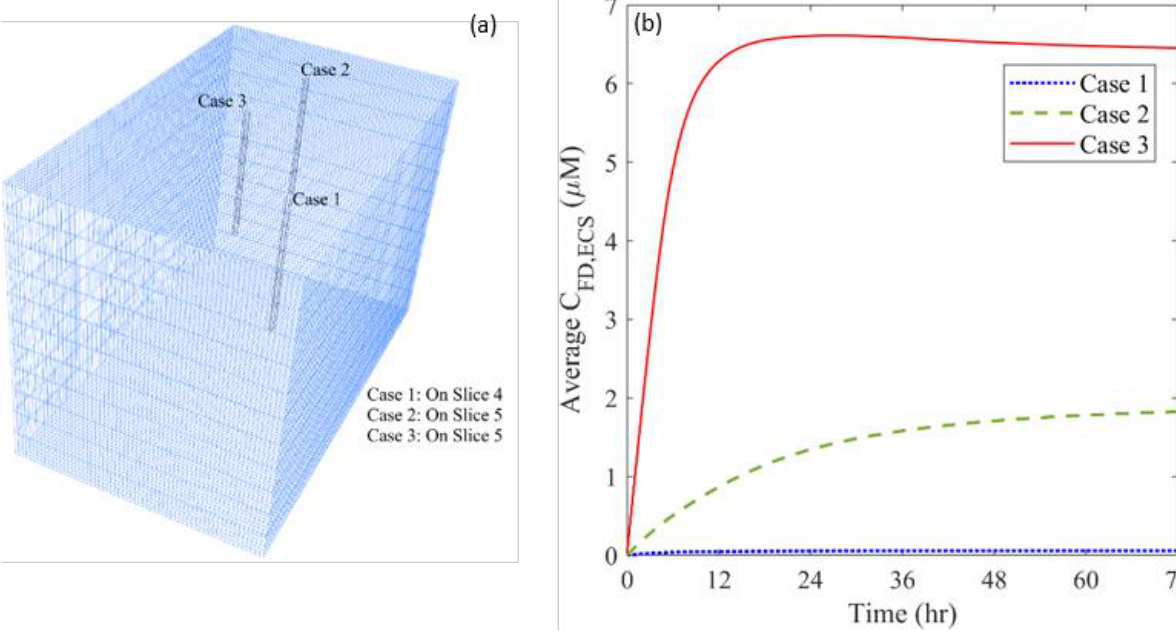
Figure 14. ( a ) Location of different infusion sites of plasma volume fraction, and ( b ) its impact on the time course of free temozolomide concentration in the brain tumor.